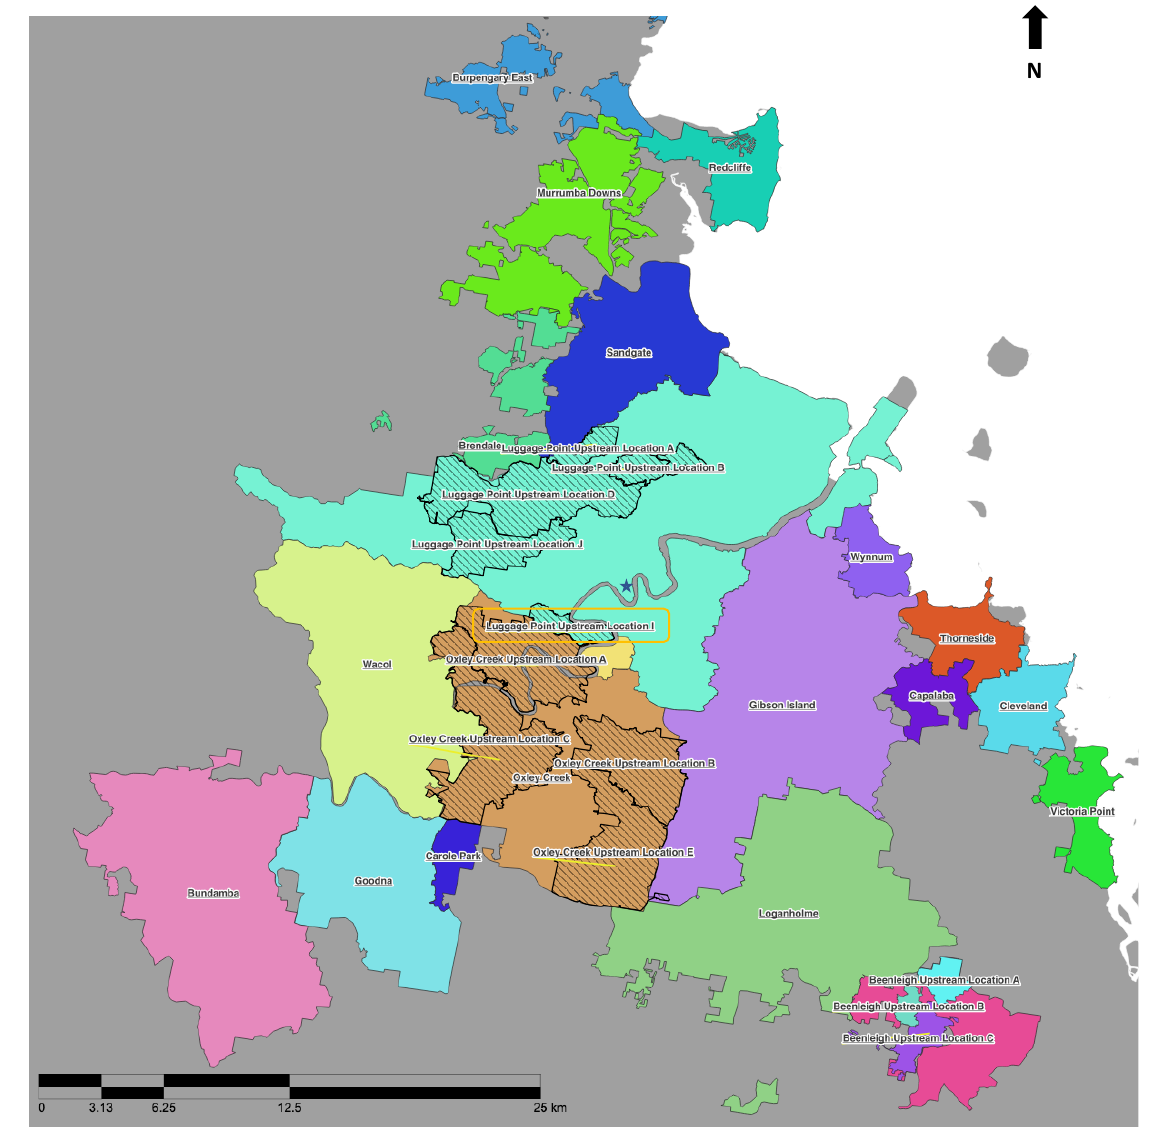
Figure 1. Catchment boundaries of sewage treatment plants (STPs, solid colours) and their respective upstream sampling sites (quilted pattern) across the Brisbane area. The yellow box highlights the Luggage Point upstream location I, and the star represents the Brisbane central business district. The coloured dots represent the suburbs of St Lucia (orange), Indooroopilly (blue), and Taringa (green). The positive predictive values (PPVs) and negative predictive values (NPVs) of wastewater detection for predicting the presence of COVID-19 reported cases were cal- culated for the two case study sites. PPVs were calculated as the proportion of positive wastewater detections that were associated with positive human case detections. For this calculation, reported cases of COVID-19 within a 10 day window of a wastewater detec- tion (5 days before and 5 days after wastewater detection) were matched with a positive wastewater detection if they occurred. NPV were calculated as the proportion of negative detections that were considered true negatives (where there were no reported cases of COVID-19 within a 10 day window (5 days before and 5 days after a wastewater sample was